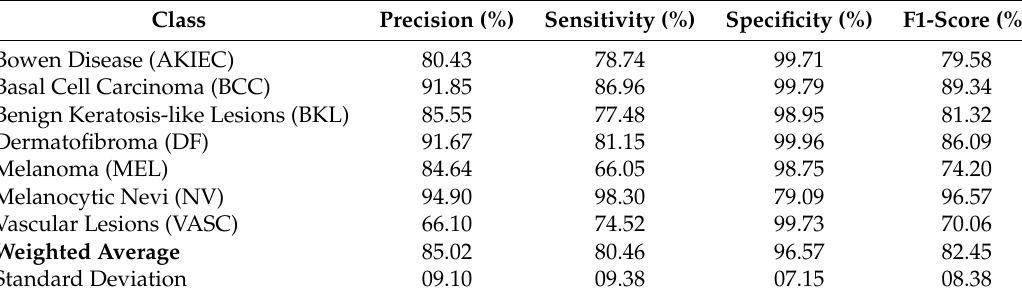
Table 4. Performance Metrics of ISIC Archive-2018 using